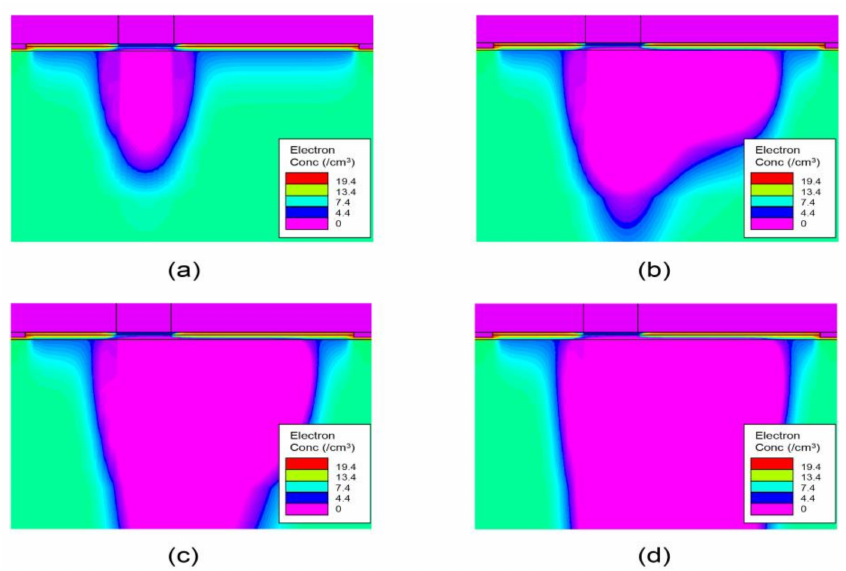
Figure 3. The electron distribution (V gate = − 10 V) in log scale of ( a ) Al 0.18 GaN back-barrier structures and proposed structure with ( b ) 3 × 10 16 cm − 3 , ( c ) 5 × 10 16 cm − 3 and ( d ) 7 × 10 16 cm − 3 concentration.